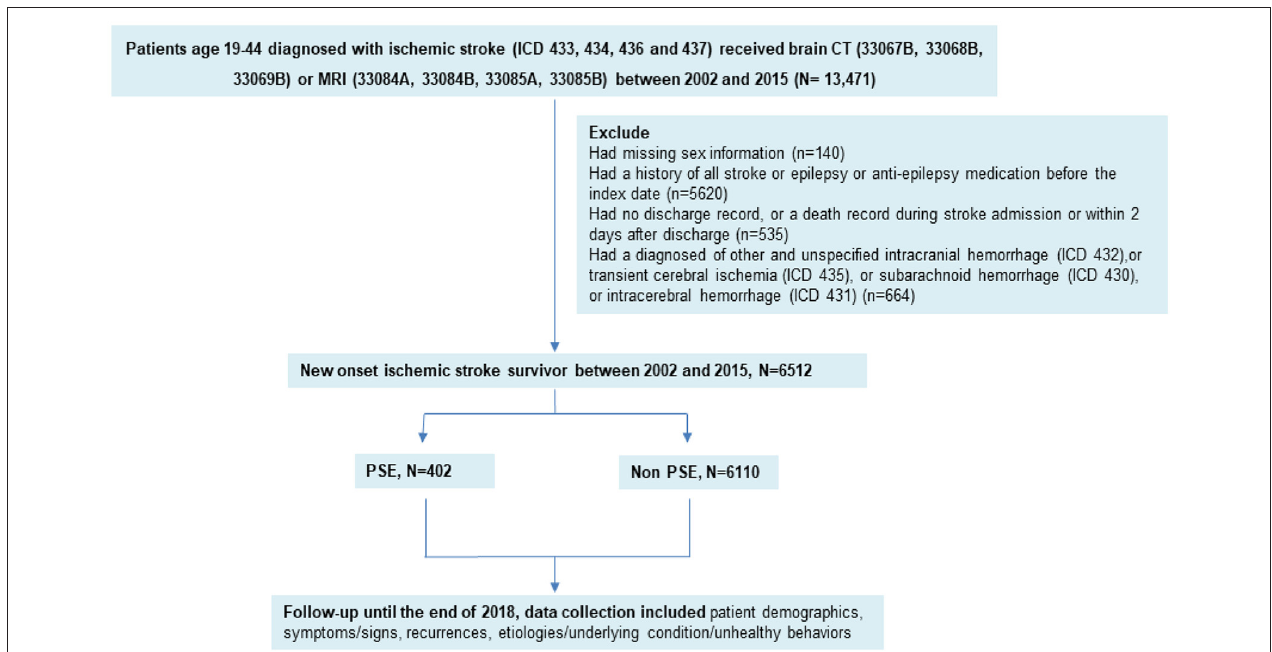
FIGURE 1 | Flowchart of patient